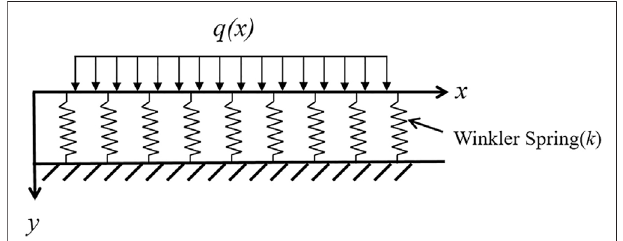
FIGURE 2 | Winkler elastic foundation beam